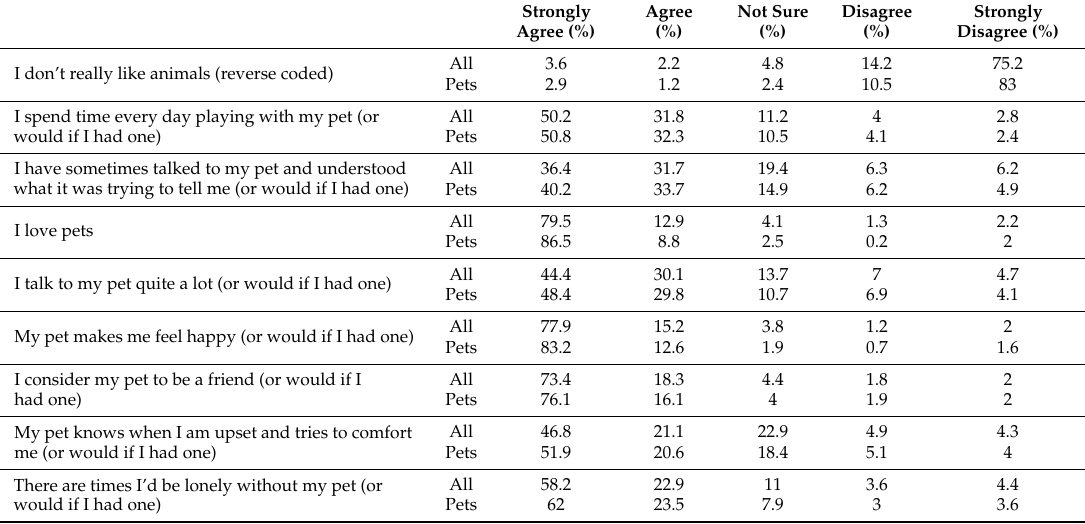
Table 2. Descriptive statistics for children’s attachment to pets for all children and pet